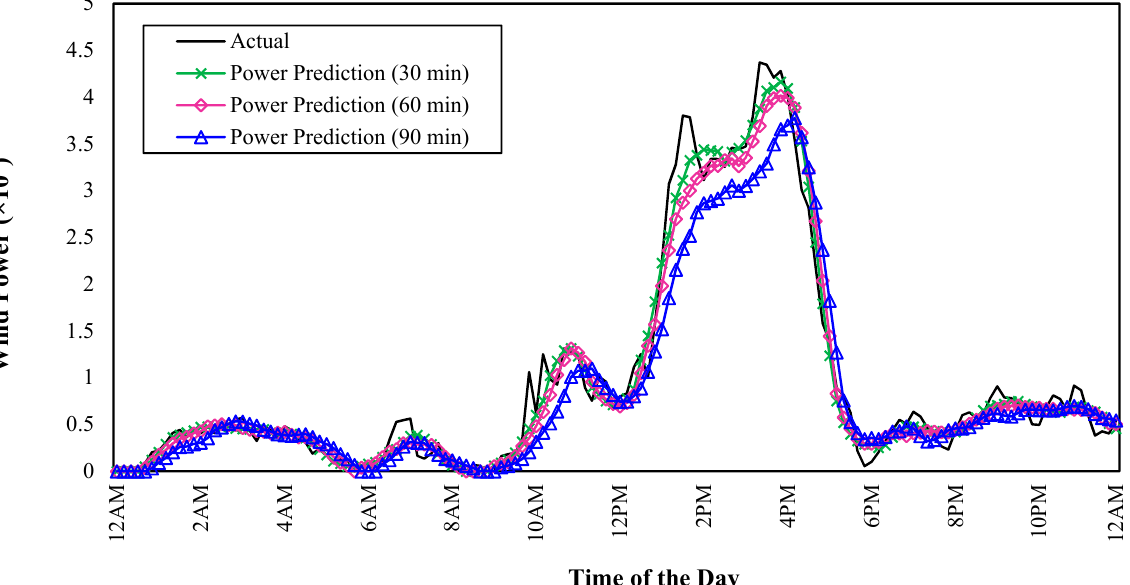
Figure 11. A sample of the power generation predicted using the NX2_LM_BL_FFT_B model with the actual measurements, at different time horizon (i.e., 10, 30, 60, and 90 min), with a high correlation of 98.71%, 98.41%, and 96.79% observed for the 30 min, 60 min, and 90 min ahead nowcasts,